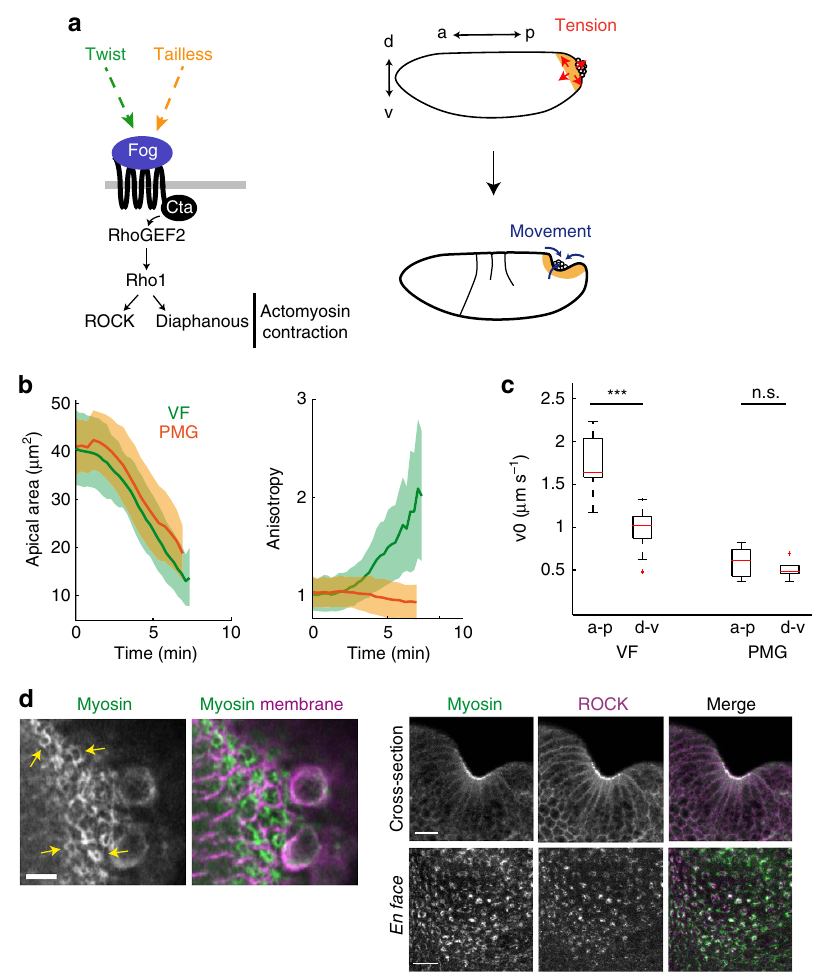
Figure 6 | Cup-like invagination of the posterior midgut is associated with actomyosin rings and isotropic tension. ( a ) Apical constriction is activated downstream of the Fog pathway in VF cells (where Fog is transcriptionally activated by Twist) and PMG cells (where Fog is transcriptionally activated by Tailless). PMG formation is driven by apical constriction of the posterior–dorsal cells forming a cup-like invagination. ( b ) Mean apical area (left) and anisotropy (right) over time during VF (green, n ¼ 119 cells, 2 embryos) and PMG (orange, n ¼ 188 cells, 3 embryos) formation. PMG cells constrict isotropically. Shaded area indicates s.d. ( c ) Box-and-whisker plot of initial recoil velocity (v0) along a-p and d-v, measured after line ablation performed in the VF ( n ¼ 15 vertical incisions and n ¼ 9 horizontal incisions) and the PMG ( n ¼ 7 vertical incisions and n ¼ 7 horizontal incisions). *** P o 0.001, n.s., not significant, t- test. ( d ) Left panels are fixed images of wild-type PMG cells, showing apical myosin organization in rings (arrows). Staining for subapical actin delineated cell boundaries. ( d , right) Images of cross-section and en face views of PMG cells from a live embryo expressing ROCK-GFP (magenta) and sqh::mCherry (green). Scale bars, 10 m m (right panels) and 20 m m (left